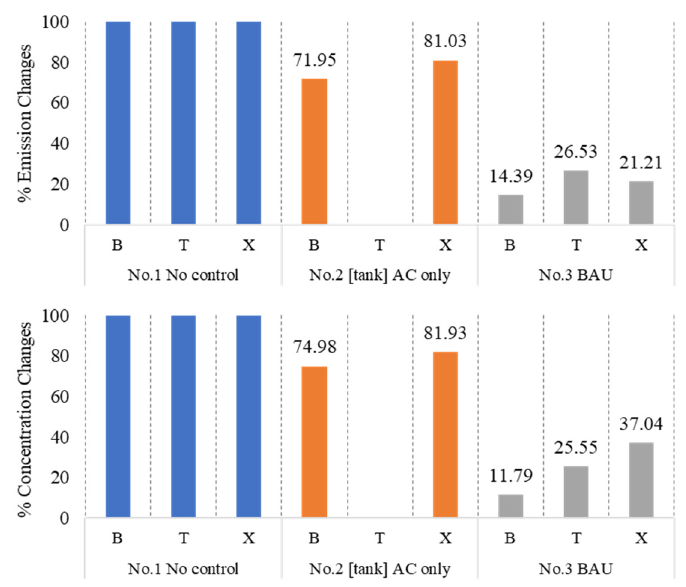
Figure 9. Success of implemented technology in past and current situations.